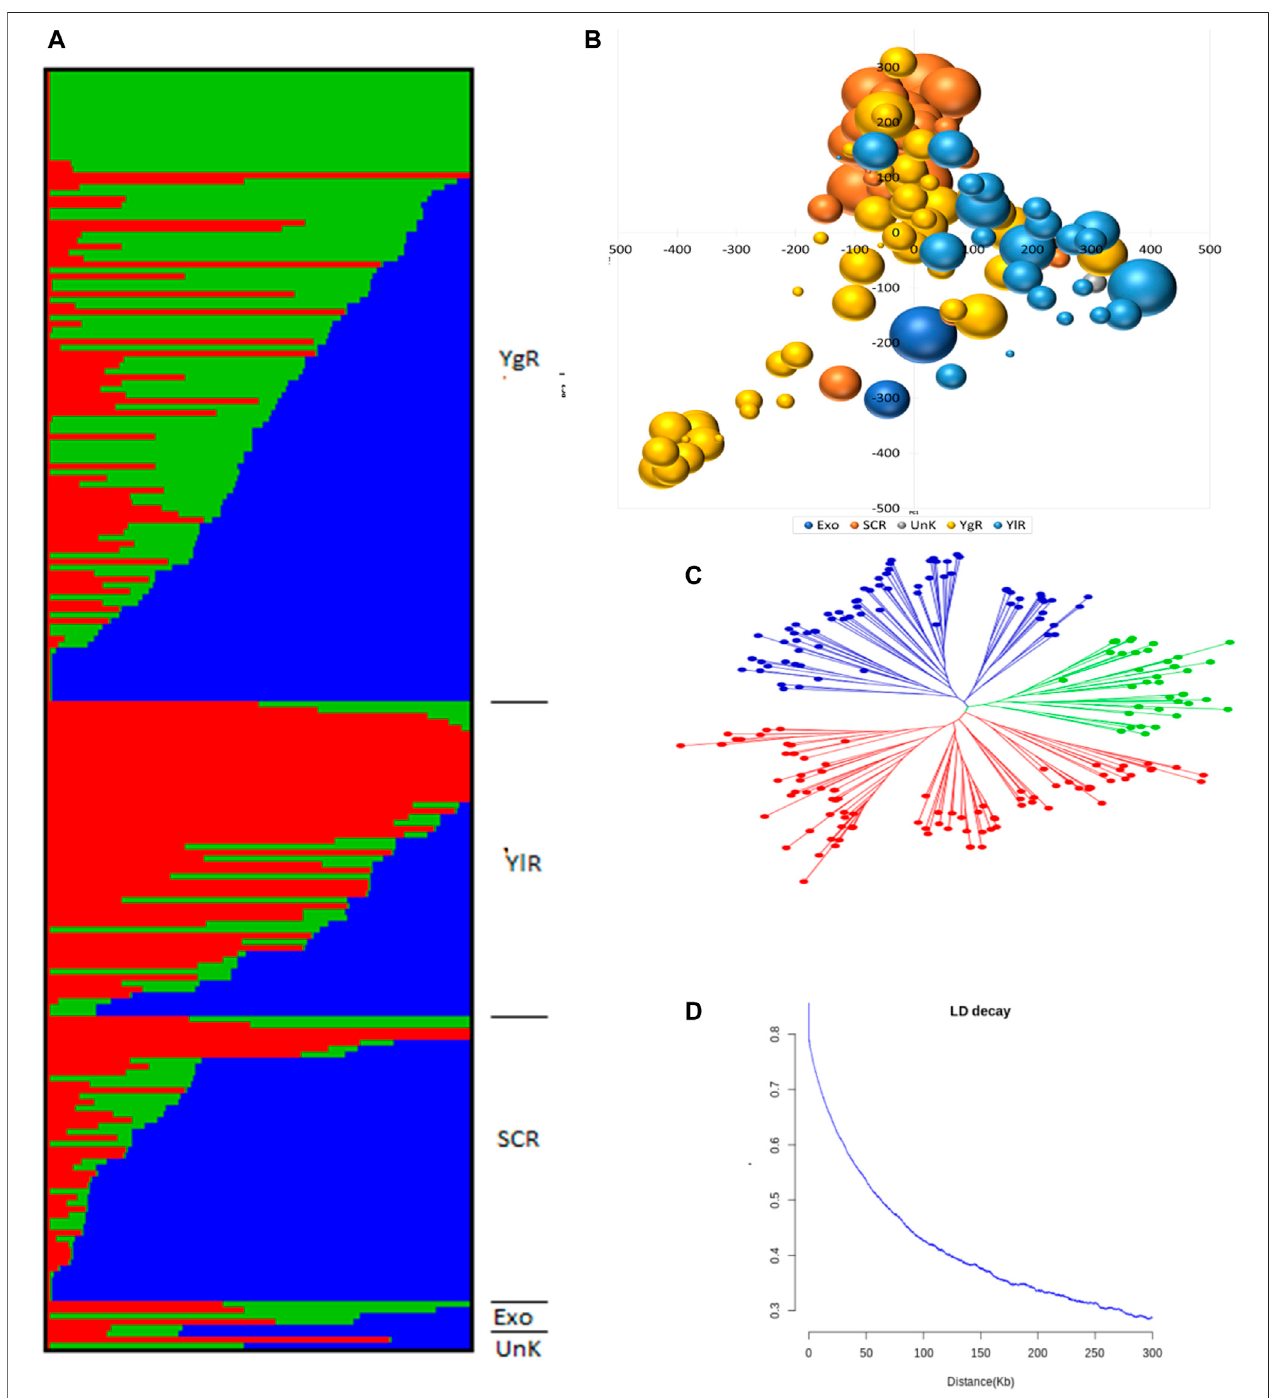
FIGURE 2 | Population Genetic Study (A) Population structure of 215 G . arboreum cotton accessions in the association panel based on modeled ADMIXTURE analysis at K (cid:2) 3. The component structural groups of Asiatic cotton are divided into cotton growing zones i.e., YgR (Yangtze River Region), YlR (Yellow River Region), SCR(SouthChinaRegion),Exo(Exotic)andUnK(Unknown) (B) Principalcomponentanalysis(PCA)plotofPC1andPC2basedon1430005genomewideSNPsscored on 215 G. arboreum accessions (C) Phylogenetic tree constructed using whole-genome SNP data, distributing genotypes into three clades as per original classi fi cation (D) Decay of linkage disequilibrium (LD) expressed as a function of physical distance (kb) and r 2 .